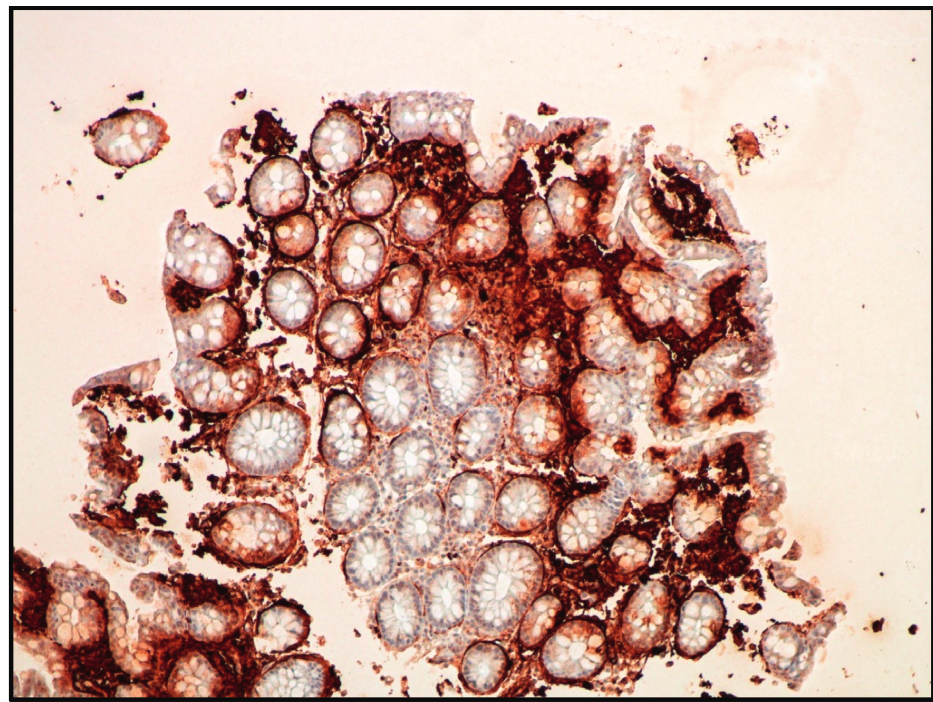
Figure 3: Colon biopsy. Immunohistochemical characterization of amyloid substance deposits, positive for AA